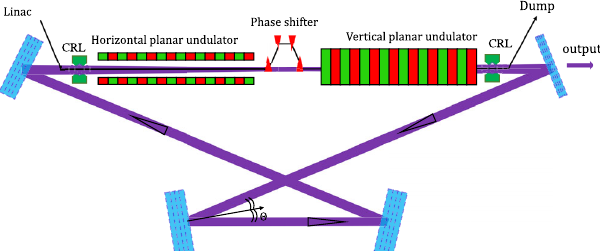
FIG. 8. A schematic configuration for the tunable cavity. Four Bragg mirrors are used. When changing the photon energy, the incidence angle of all four mirror must change simultaneously.